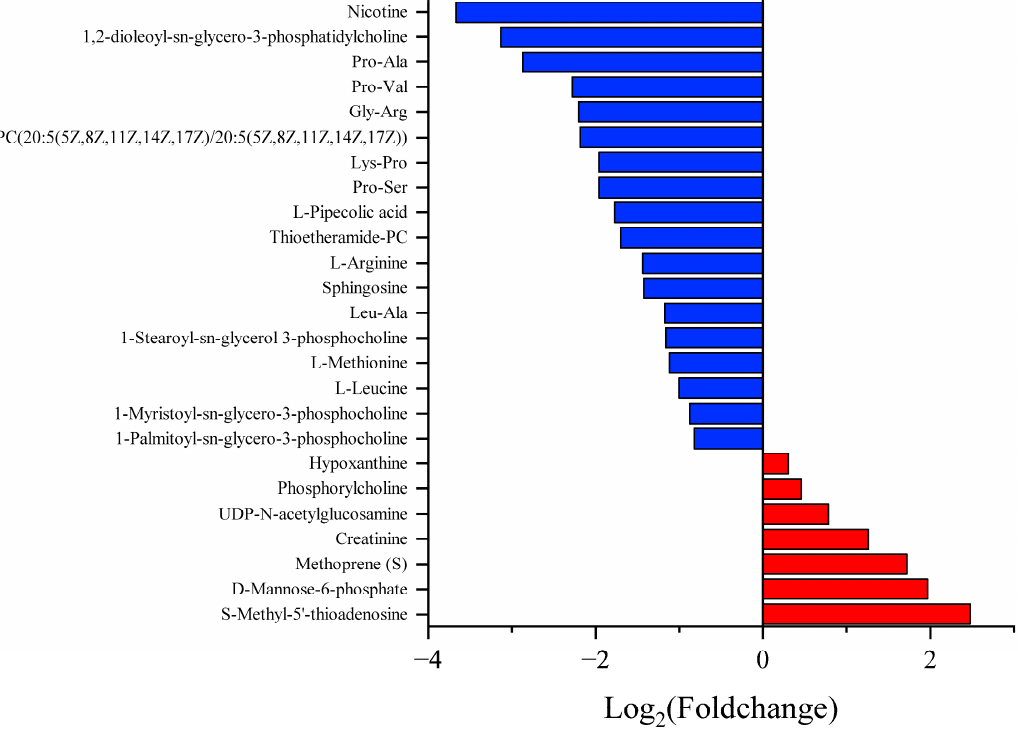
Figure 3. Differentially accumulated metabolites in the liver between two groups in the positive polarity mode (BR vs.